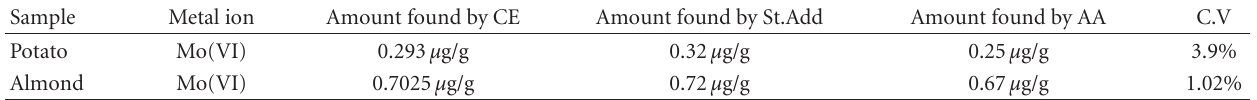
Table 2: The determination of amount of Mo(VI) in potato and almond samples.